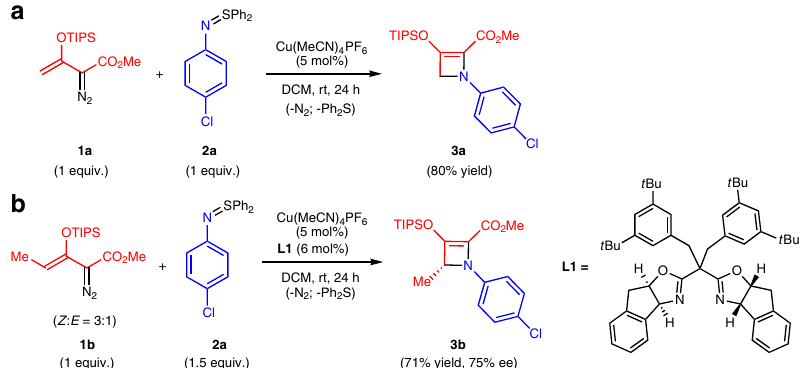
Fig. 2 Azetine ring construction. a [3 + 1]-Cycloaddition of methyl 3-triisopropylsil(TIPS)oxy-2-diazo-3-butenoate ( 1a ) with S , S -diphenyl N -( p - chlorophenyl)sul fi nylimine ( 2a ) catalyzed by copper(I) tetrakis(acetonitrile). b Asymmetric synthesis of donor – acceptor azetine using copper(I) catalysis with chiral sabox ligand L1 .